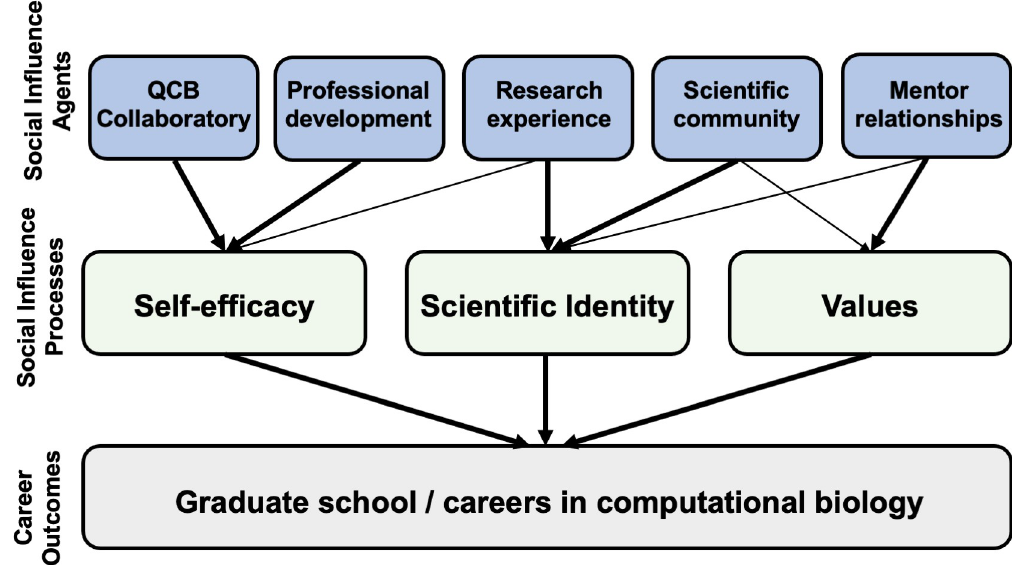
Fig 1. Schematic of the components and outcomes of the Bruins-in-Genomics Summer undergraduate research program. The social influence agents, social influence processes and their relationship to career outcomes are